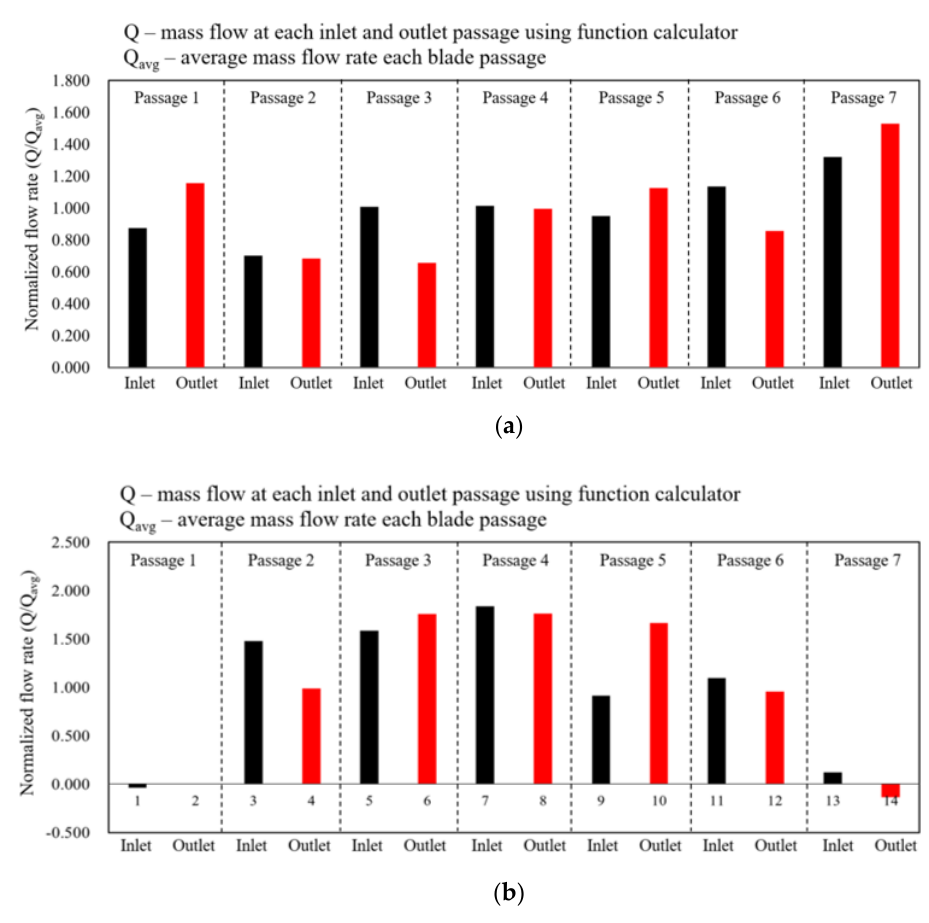
Figure 20. Normalized flow rate of runner channels under the runaway condition: ( a ) Full-scale model (blade 1 – 7); ( b ) laboratory-scale model (blade 1 – 7).